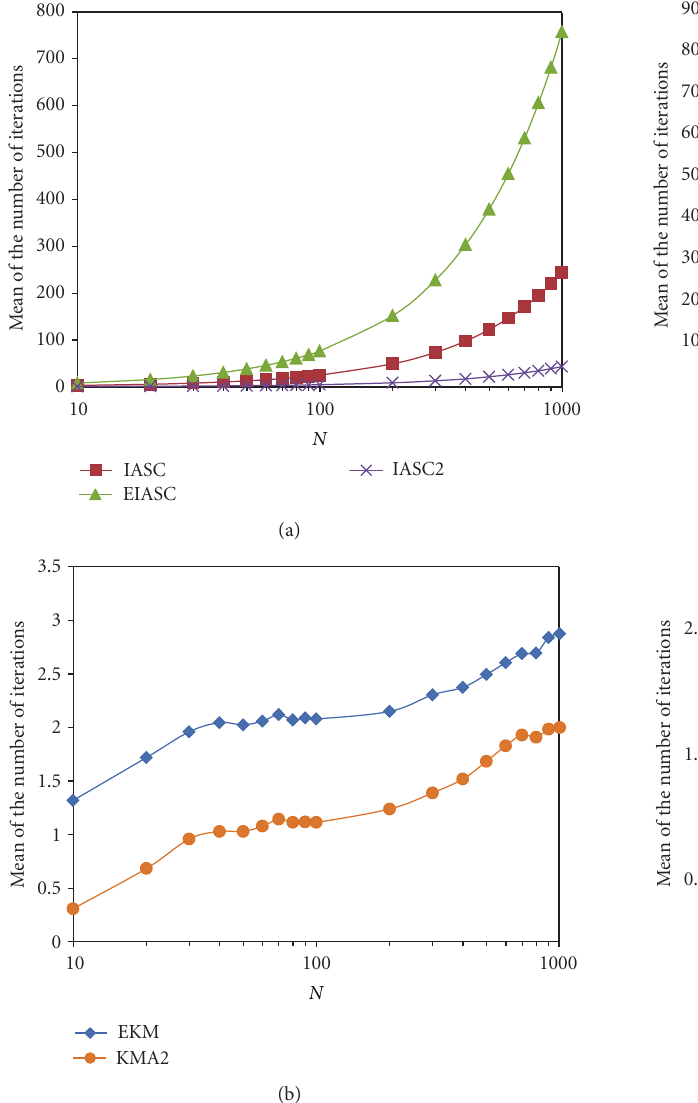
Figure 9: Left-sided random FOU, iterations, (a) IASC-type algo- rithms and (b) KM-type algorithms.